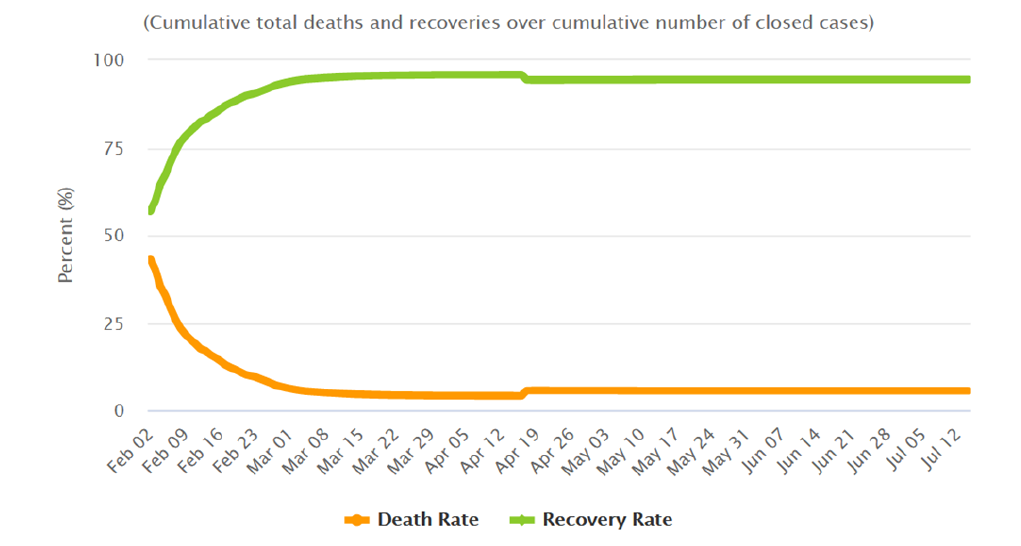
Figure 4. Case Fatality Rate as measured in China since the beginning of February 2020. The value measured the 4th of March of 5.78% was taken for the model (Source of information https://www.wo rldometers.info/coronavirus/ (consulted on 11